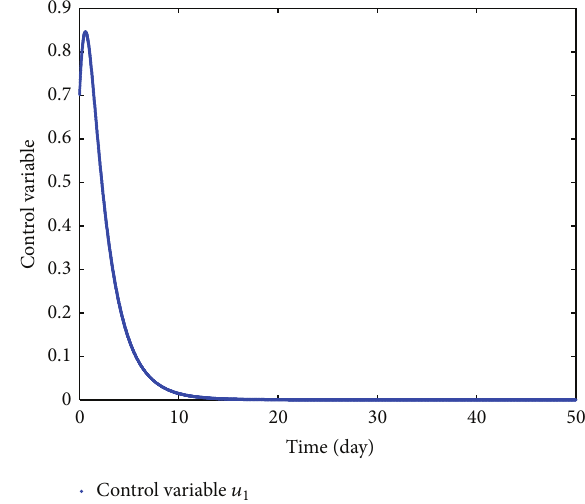
Figure 7: The plot shows the control variable 𝑢 1 .